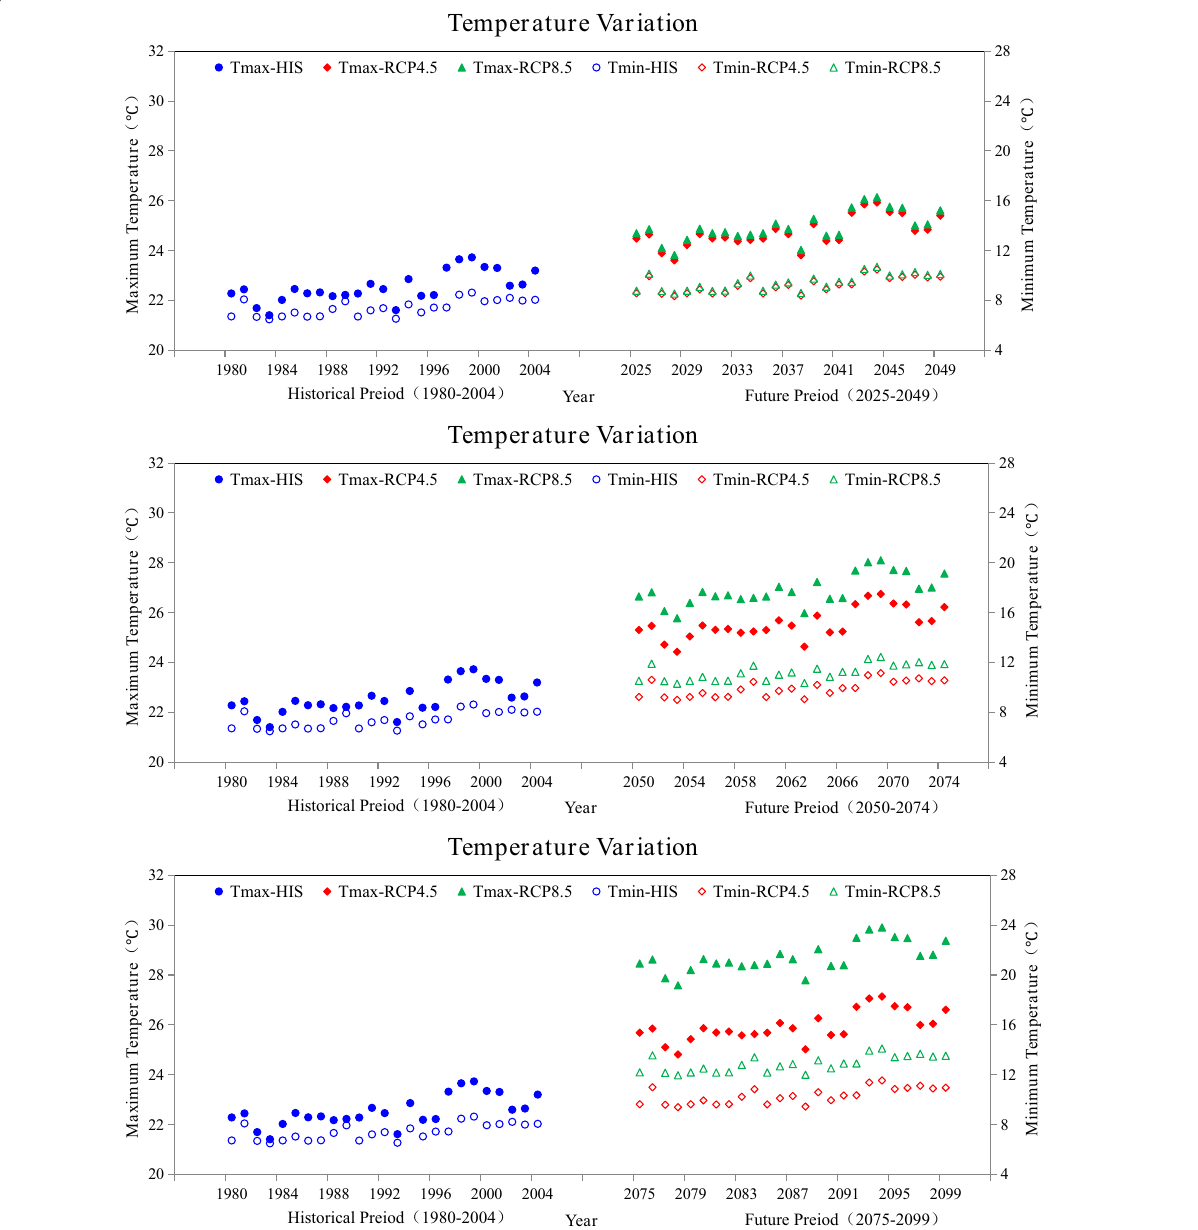
Fig. 6 The change tendency of maximum and minimum temperatures in the historical baseline period and in three future periods, i.e., 2025–2049 (top), 2050–2074 (middle), and 2075–2099 (bottom), with RCP4.5 and RCP8.5